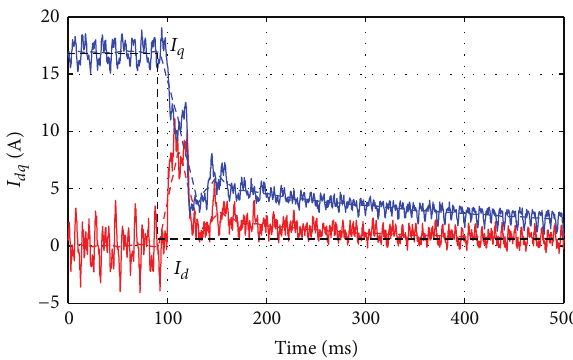
Figure 13: Step-down response in active power from 21kW to 1kW, 𝑄 ∗ = 0